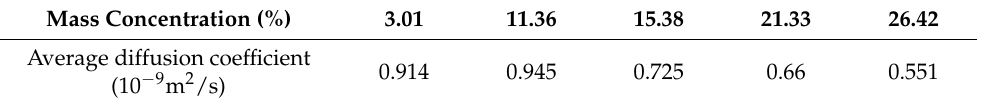
Table 4. The average diffusion coefficients of NaCl solution with different mass concentration.